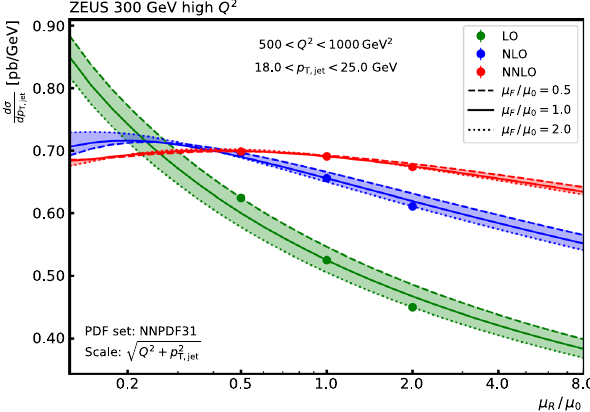
Fig. 3 The scale dependence for a single bin in jet p T with 25 < p T , jet < 35GeV for a range 30 < Q 2 < 42GeV 2 from H1 (left) and in jet p T with 18 < p T , jet < 25GeV for a range 500 < Q 2 < 1000GeV 2 from ZEUS (right). The bands show